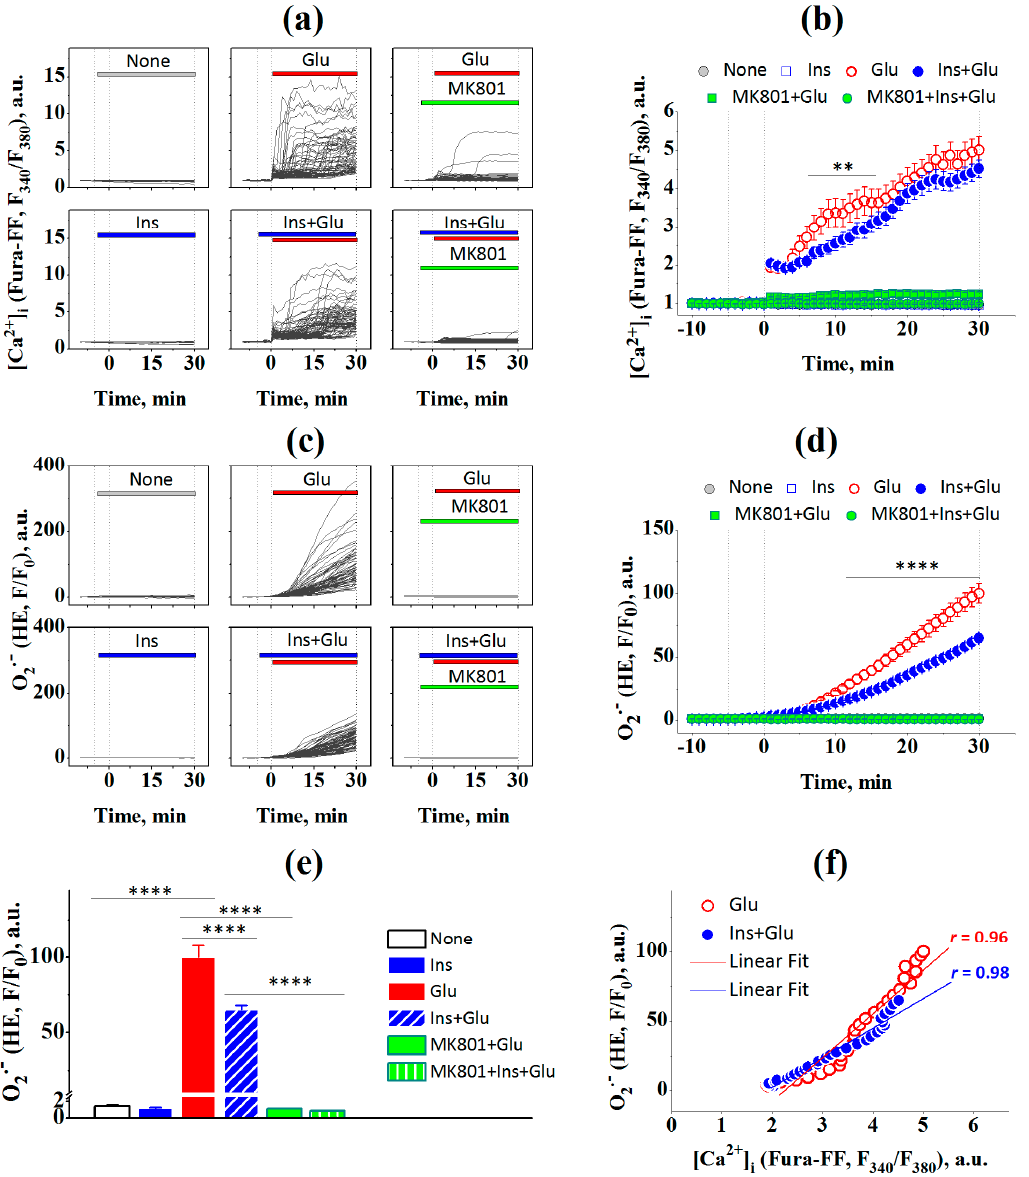
Figure 2. Insulin prevents the increase in intracellular superoxide ([O 2 − • ]) and calcium ([Ca 2+ ] i ) in rat cortical neurons exposed to glutamate. ( a ) The dynamics of Fura-FF fluorescence, a measure of intracellular Ca 2+ , in single neurons (gray lines) treated with none (None; n = 103), 100 nM insulin (Ins; n = 94), 100 µ M glutamate (Glu; n = 64), 100 nM insulin and 100 µ M Glu (Ins + Glu; n = 72), MK-801 (10 µ M) with 100 µ M glutamate (MK801 + Glu; n = 100), and MK 801 with 100 nM insulin and 100 µ M Glu (MK801 + Ins + Glu; n = 100). The data are obtained at every time point, at 60-second intervals, within 30 min of glutamate exposure. ( b ) The dynamics of Fura-FF fluorescence